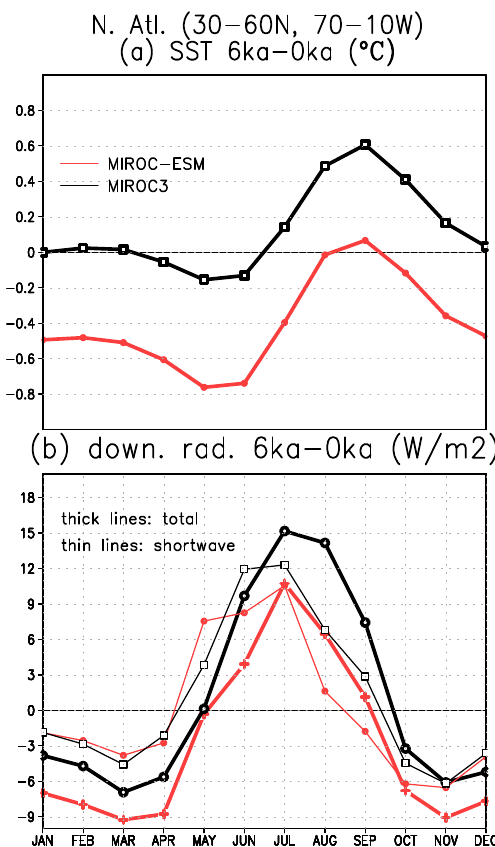
Fig. 8. (a) Seasonal evolution of the SST change (6–0ka) ( ◦ C) over the North Atlantic region (30–60 ◦ N, 70–10 ◦ W) for MIROC-ESM (red line) and MIROC3 (black line). (b) The same as (a) but for the downward radiation change (Wm − 2 ) at the surface. The thick lines show total radiation changes and the thin lines shortwave radiation